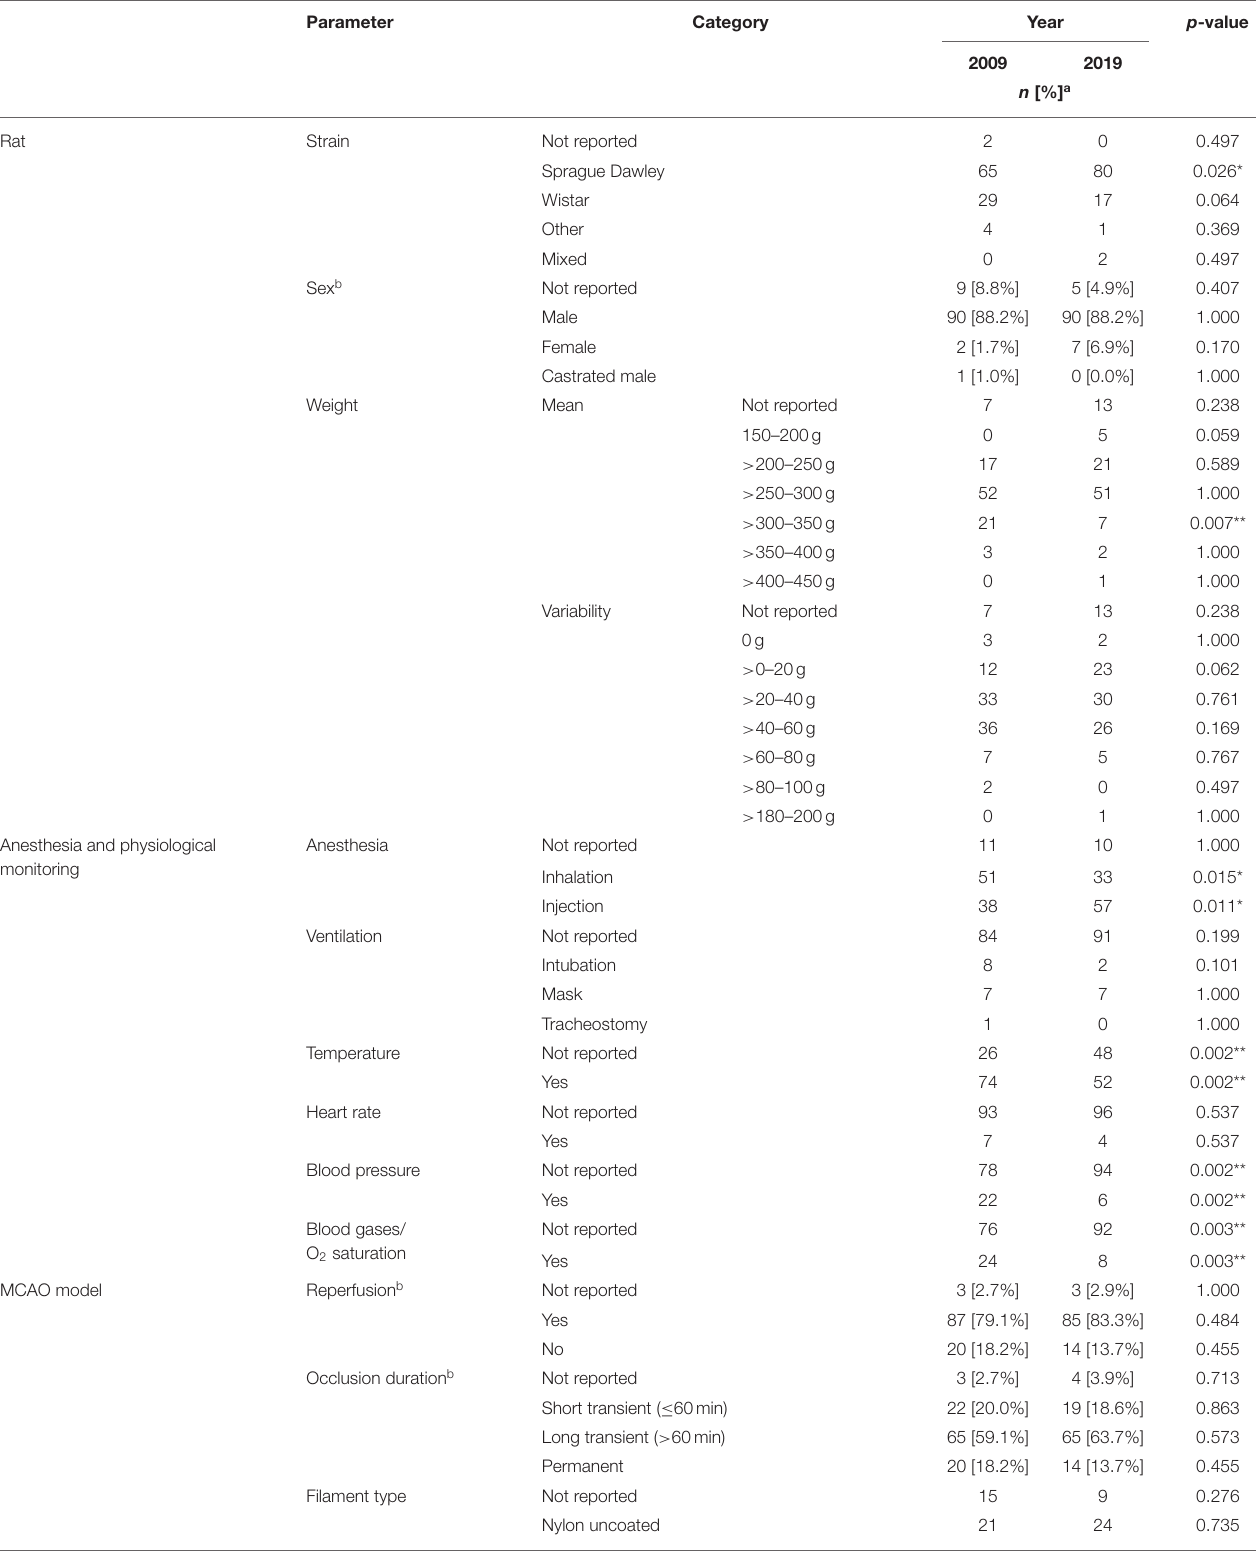
TABLE 2 | Basic experimental characteristics extracted from the studies included in the